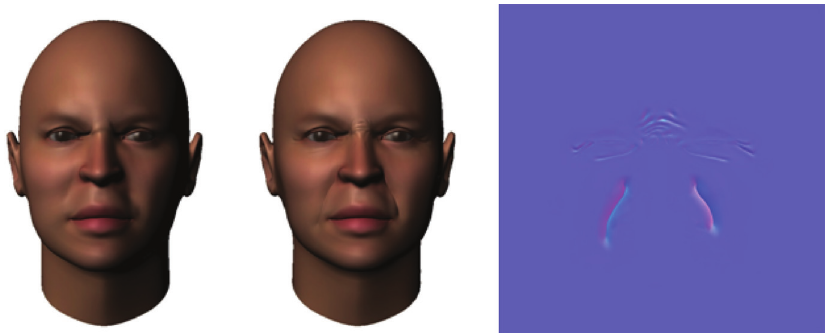
Figure 21. Wrinkle Map Example: Simple Shading Model (Left), Wrinkle Map Applied (Center), and Used Tangent Space Wrinkle Normal Map